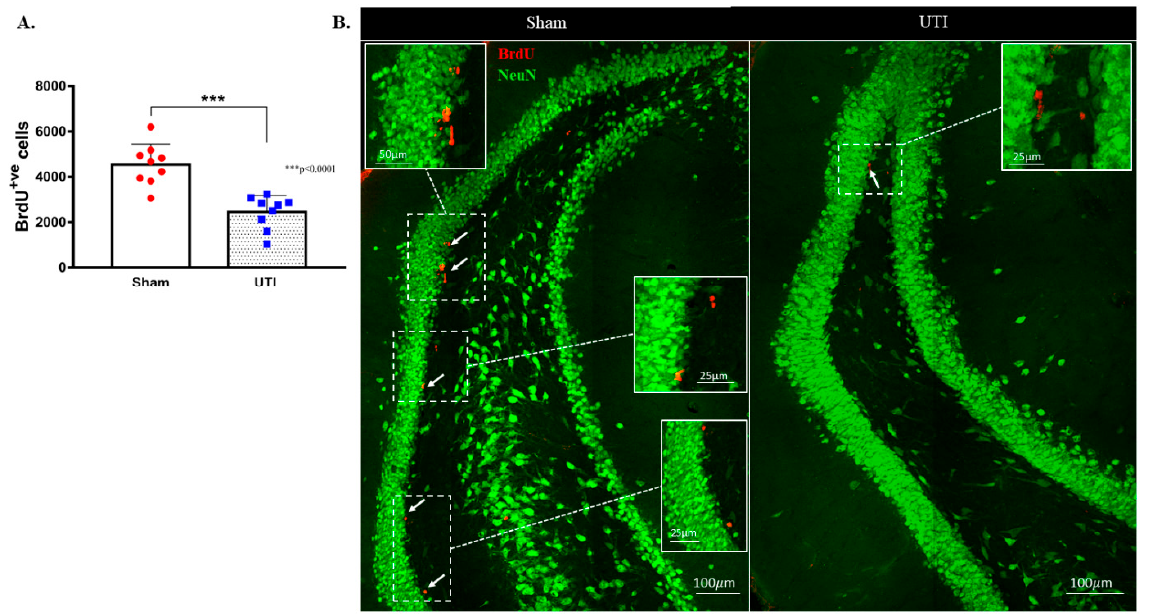
Figure 4. Decrease in the proliferation of DG NSCs on day 4 post infection. ( A ) Stereological quantification of BrdU-labeled cells in the DG of the sham group ( n = 9) and rats with a UTI ( n = 9) sacrificed on day 4 post infection. Unpaired Student’s t -test was used to determine the statistical significance between the sham ( n = 9) and UTI ( n = 9) groups. Each bar represents the average ± SEM of BrdU-positive cells per group and each dot represents the measured number in each rat. This method of presentation was followed for all subsequent figures. ( B ) Representative confocal images showing immunofluorescence labeling of NeuN (green) and BrdU (red; arrows) in the DG of the sham group and rats with a UTI. Images were taken as Z stacks and tile scan using a 40 × -oil objective.